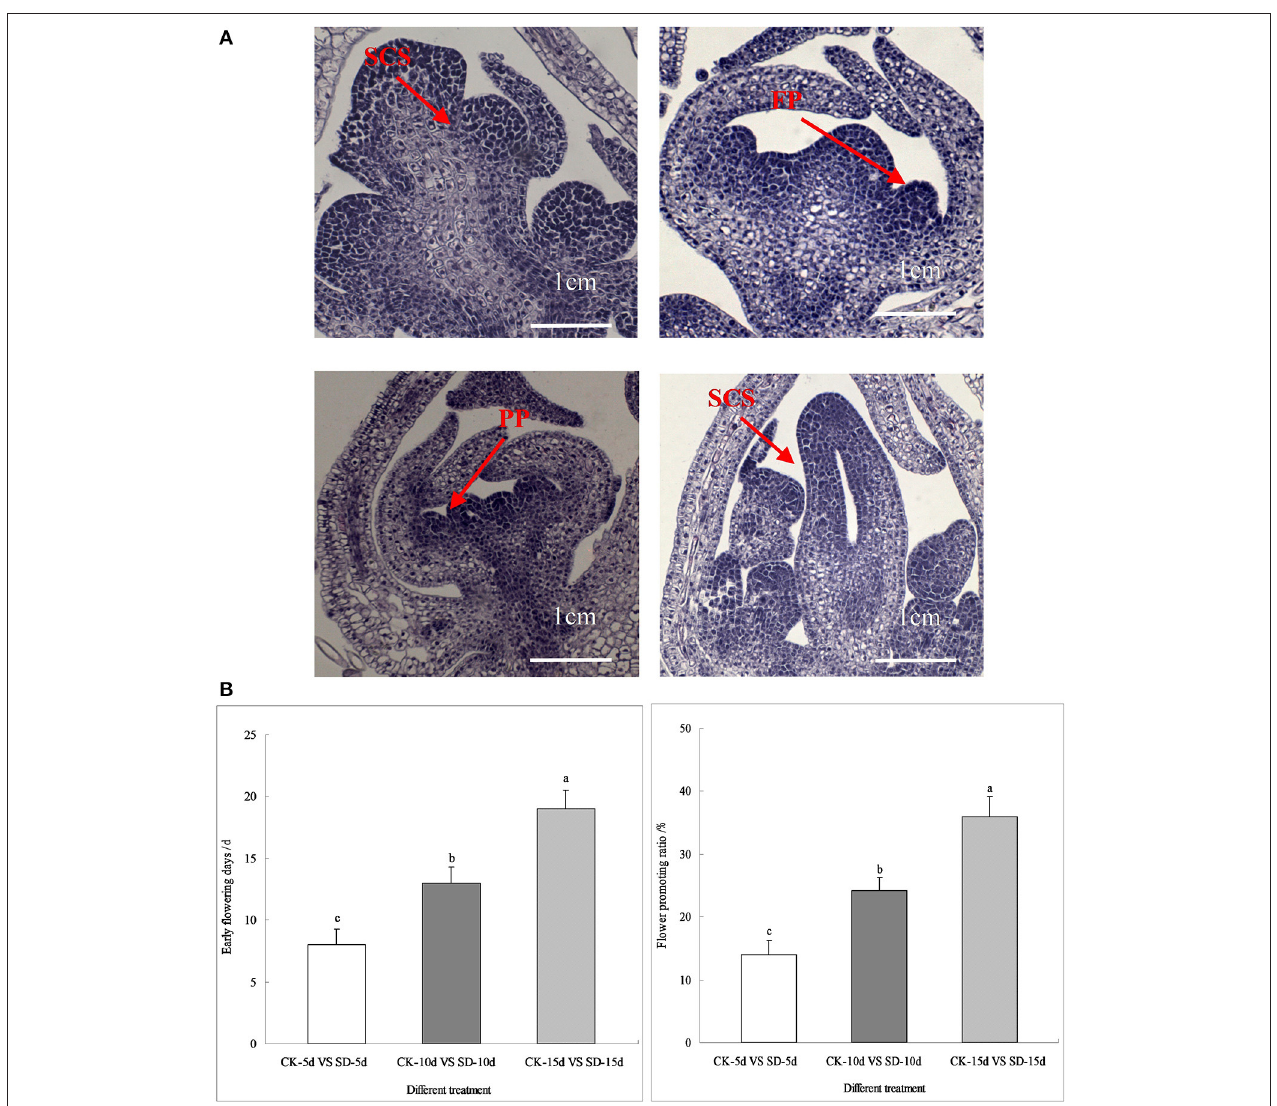
FIGURE 1 | Flower bud differentiation, early flowering days and flower promoting ratio of adzuki bean. (A) Pictures of flower bud differentiation processes under different short-day photoperiod treatments. There were three treatments (CK-natural lighting, SD-5d, SD-10d, SD-15d). (B) Statistics of early flowering days and flower promoting ratio under different short-day photoperiod treatments (CK-5d vs. SD-5d, CK-10d vs. SD-10d, CK-10d vs. SD-10d). Different letters were represented as Values are means ± S.E. The different lowercase letters above each bar chart indicate statistical significance at 0.05 level by